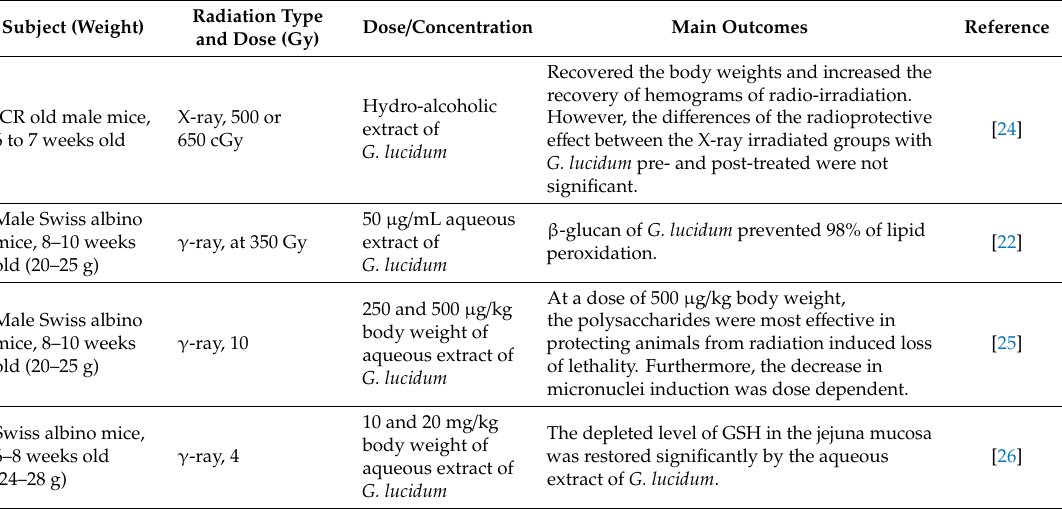
Table 3. Summary of articles focused on the in vivo radioprotective e ff ect of G. lucidum included in the systematic